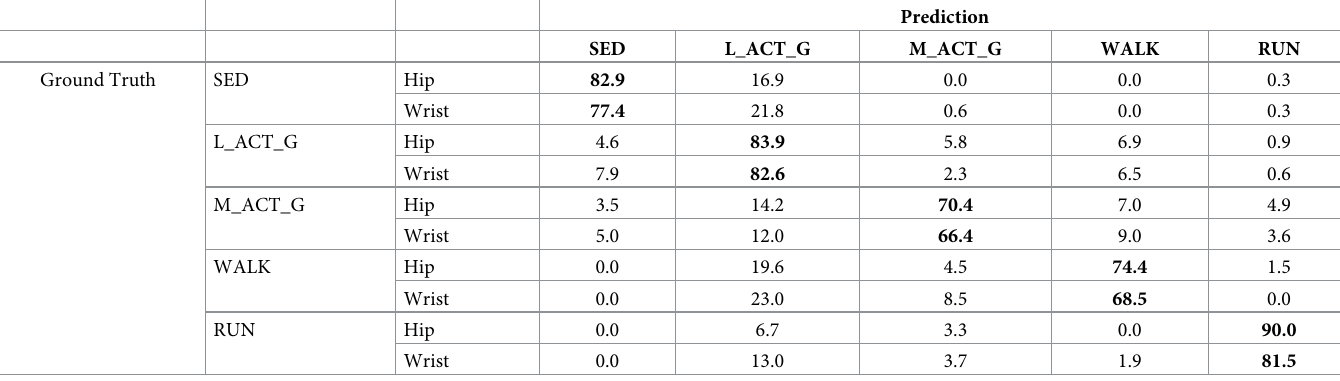
Table 2. Confusion matrix for the hip and wrist random forest physical activity